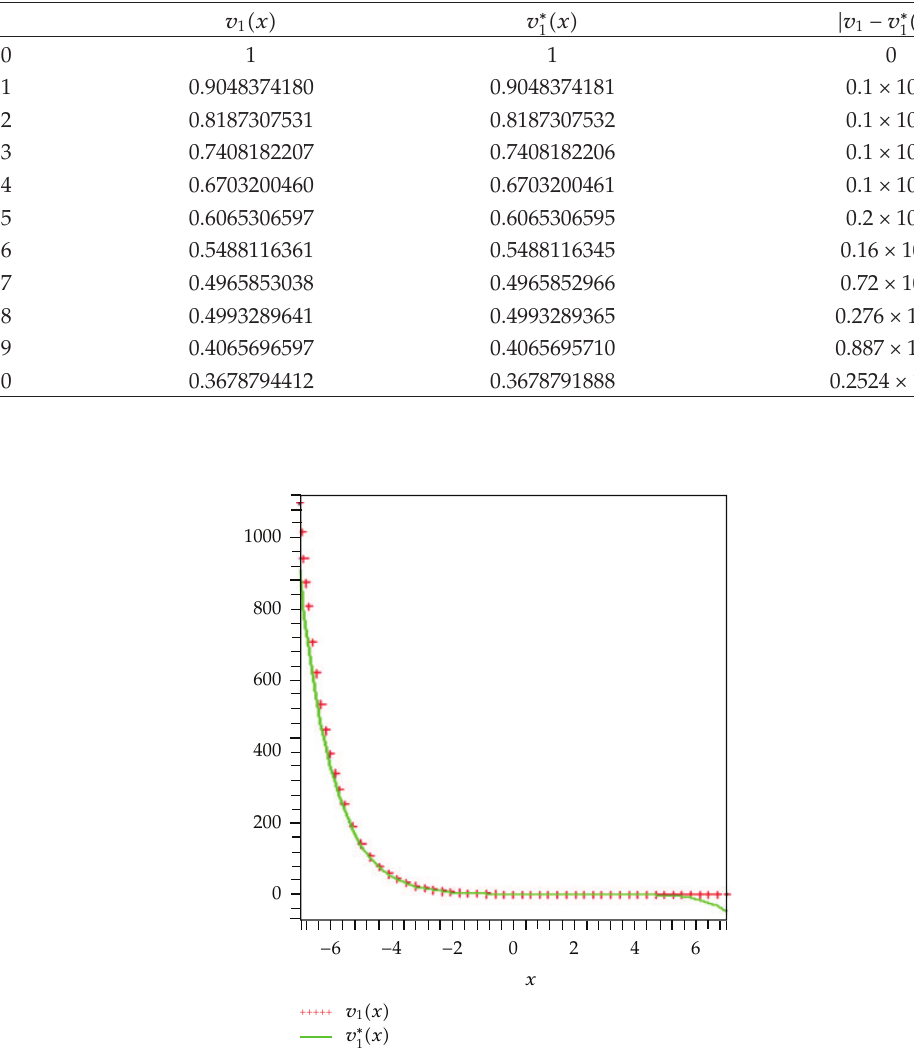
(cid:3) x (cid:4) variational 1